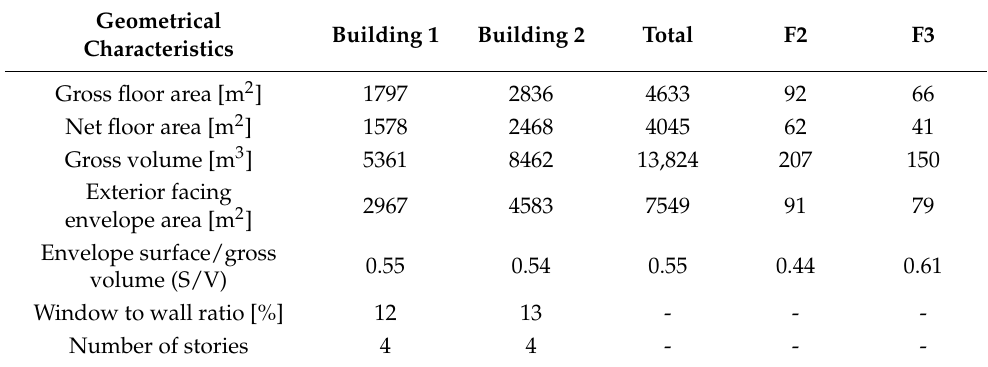
Table 3. Geometrical characteristics of the public residential housing complex (after renovation) and details about the selected flats (F2 and